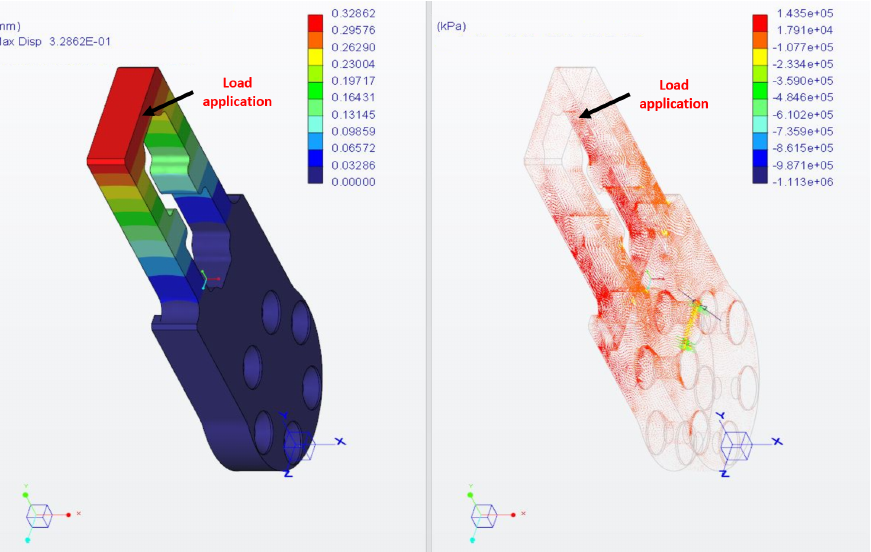
Figure 3. Results of the FEM analysis on the metallic finger simulating the application of a 100-N load on the top. On the right, the principal stresses are shown, whereas on the left, the structure displacement is depicted. The software used for the simulations was Creo